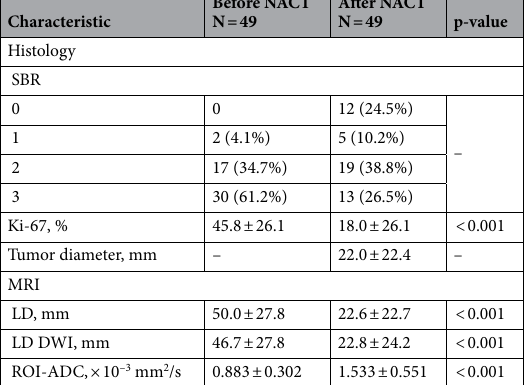
Table 2. Tumor characteristics on histology and MRI before and after NACT. SBR Scarff-Bloom-Richardson grade, Ki-67 Ki-67 proliferation index, LD largest diameter, ROI region of interest, ADC apparent diffusion coefficient, NACT neoadjuvant chemotherapy, DWI diffusion-weighted imaging, MRI magnetic resonance imaging.